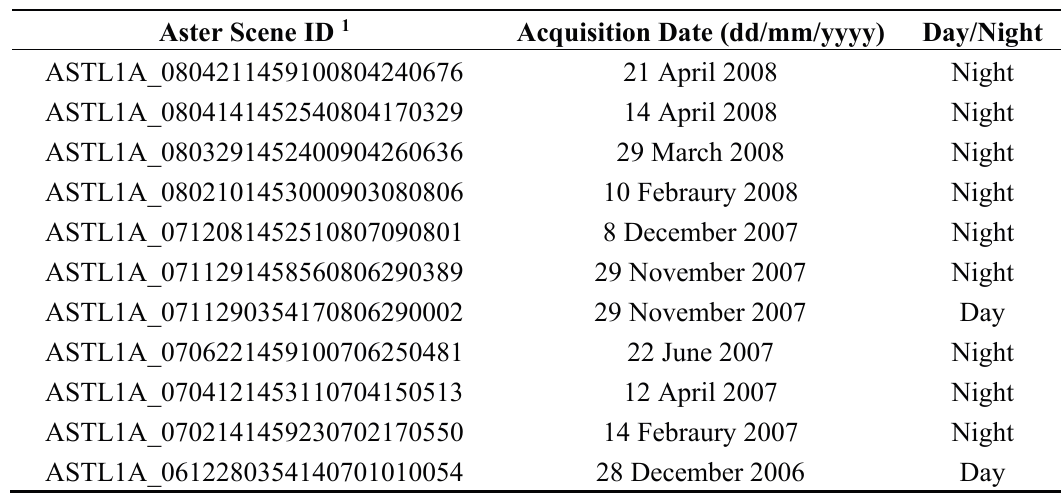
Table 1. ASTER scenes used in this